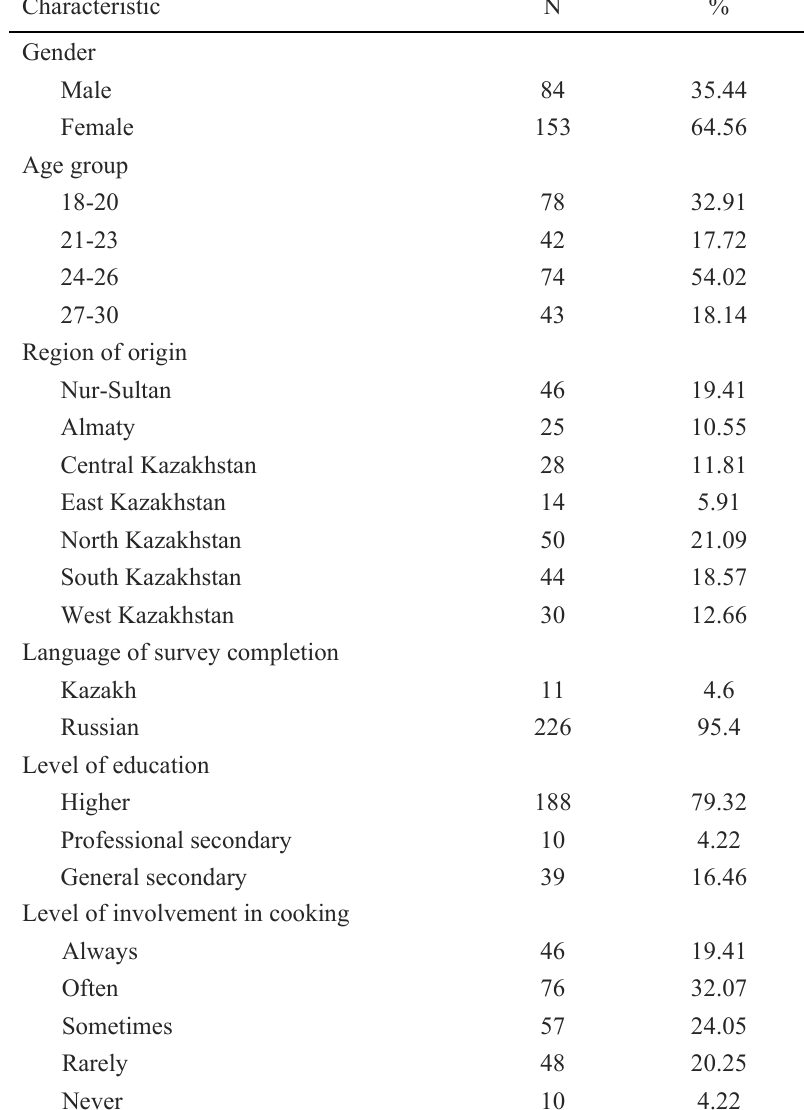
Table 1. Socio-demographic characteristics of participants